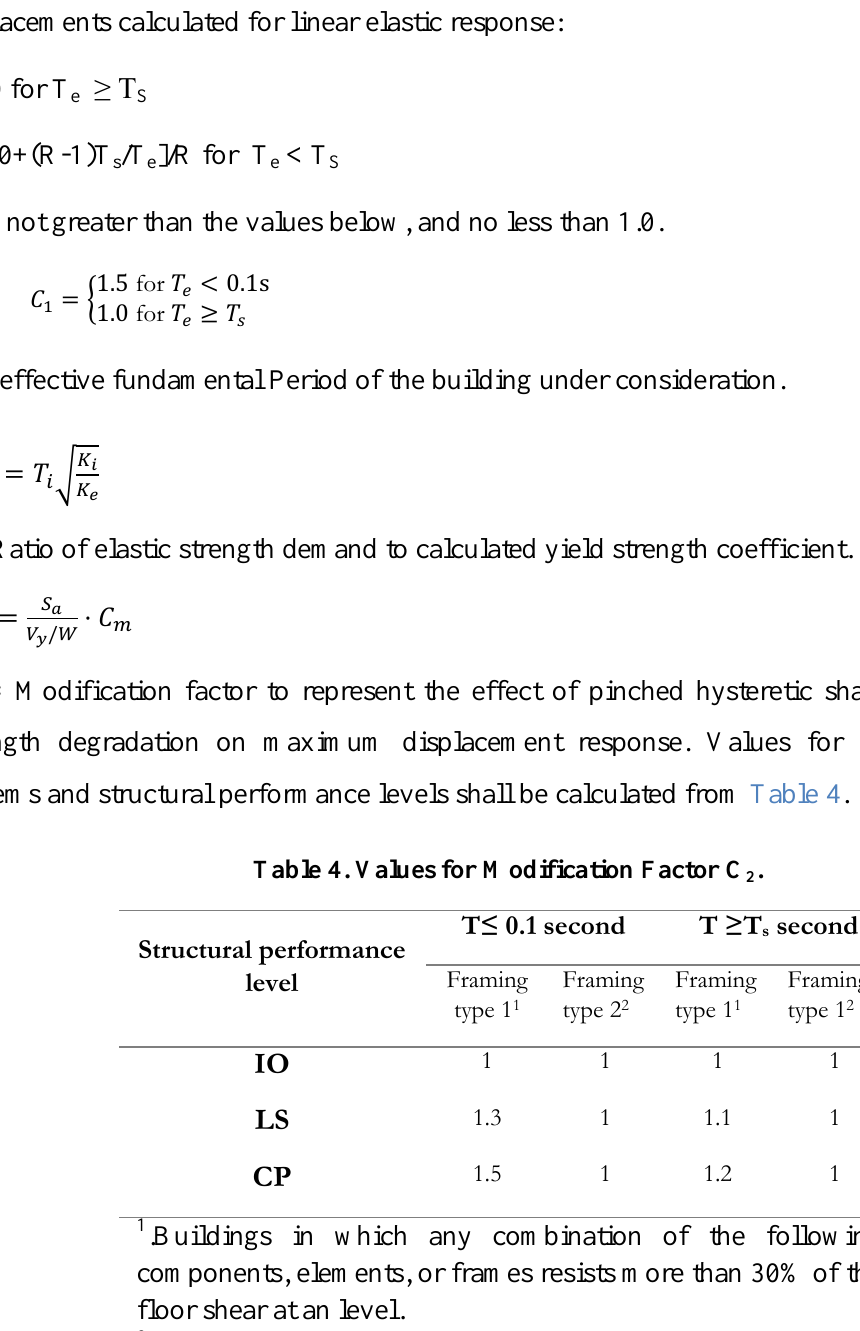
Table 3. Values for Modification Factor C